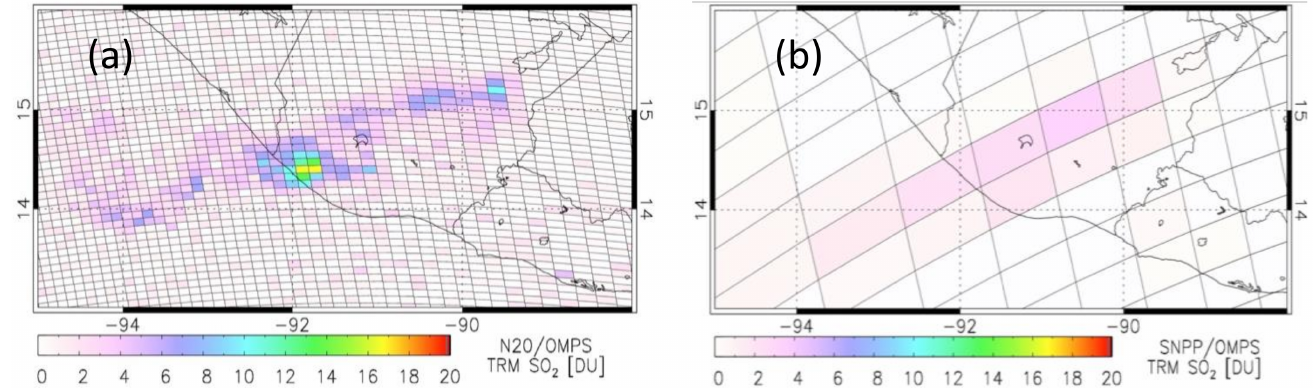
Figure 2. The high-resolution NOAA-20/OMPS instrument ( a ) offered greater detail of the SO 2 plume than the low- resolution SNPP/OMPS instrument ( b ) after the eruption of the Fuego volcano (Guatemala) on 1 February 2018. Footprints (IFOVs) of the instruments are overlaid on the maps, showing a much higher resolution offered by NOAA-20/OMPS. Such high-resolution measurements reveal greater details and cover a larger portion of the volcanic plume.